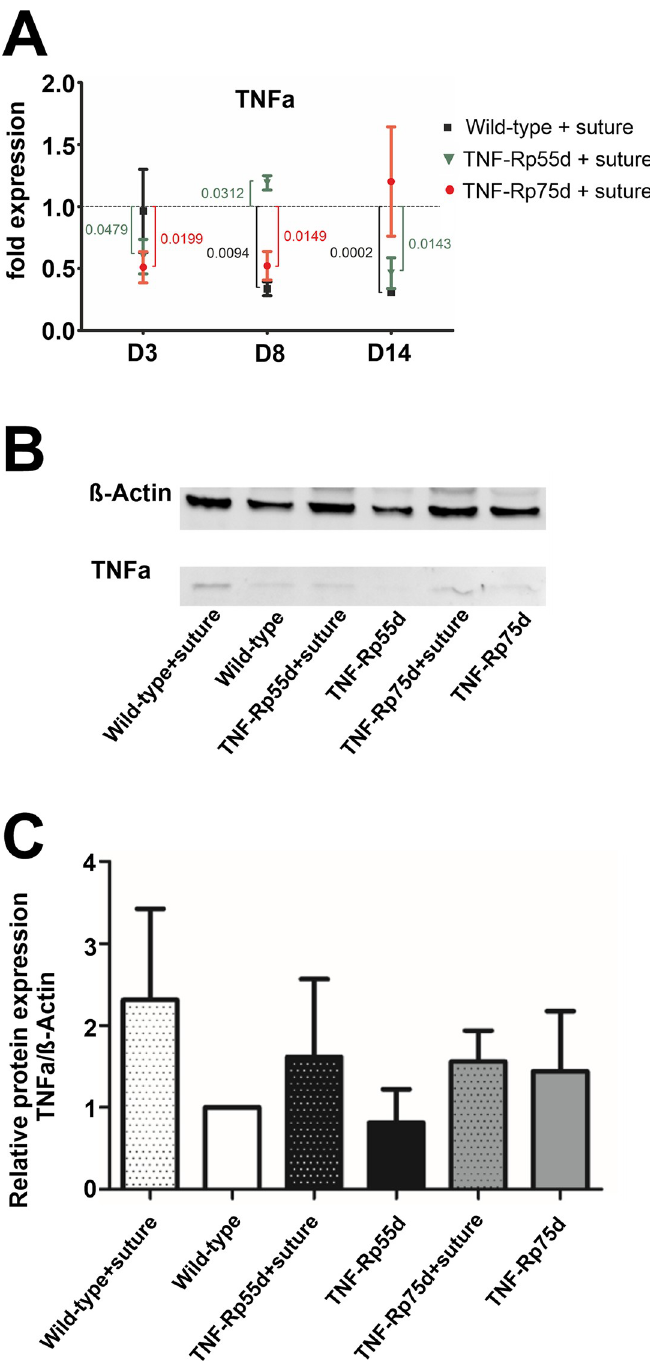
Fig 4. Influence of suture placement on TNF α expression. A: Differential mRNA expression TNF- α mRNA expression in wild-type and TNF-Rp55d mice and TNF-Rp75d mice 3 days, 8 days, and 14 days after suture. Data are normalized to VEGF-A expression values of the respective genotype without suture (= 1). n = 2–3. B, C: Detection of soluble TNF- α in representative western blot of corneal lysates from wild-type, TNF-Rp55d mice, and TNF-Rp75d mice without or with suture intervention at day 14 (B ). β -Actin served as loading control. Bar charts illustrates densitometric analysis of relative protein expression of soluble TNF- α / β -Actin ( C ). n = 4 Uncropped blots are shown in S3 Fig. and in the data repository.